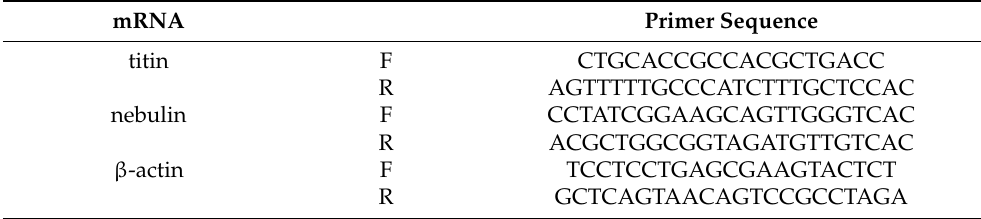
Table 3. Sequences of primers for real-time PCR. F: forward; R: reverse. mRNA Primer